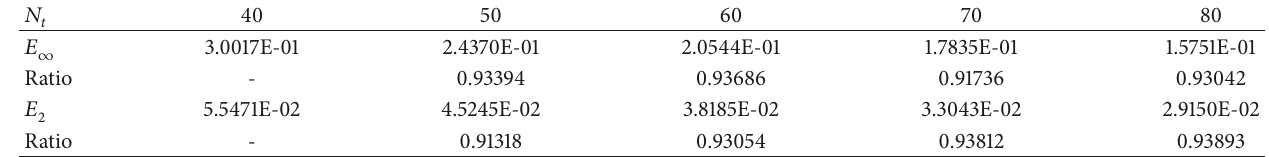
Table 2: Errors and ratios in time of the characteristic finite difference scheme (CFD).